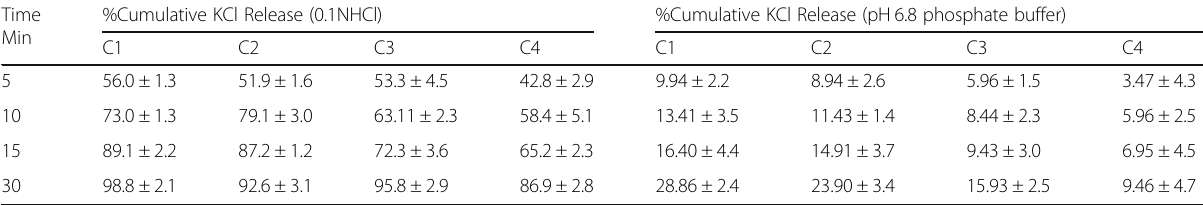
Table 3 In vitro release studies of various coated compositions of KCl Time